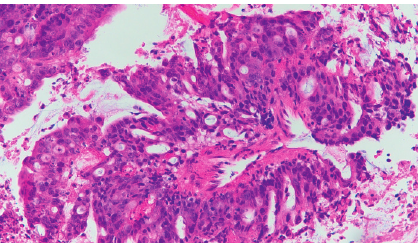
Figure 3: Invasive moderately differentiated adenocarcinoma with extracellular mucin production.